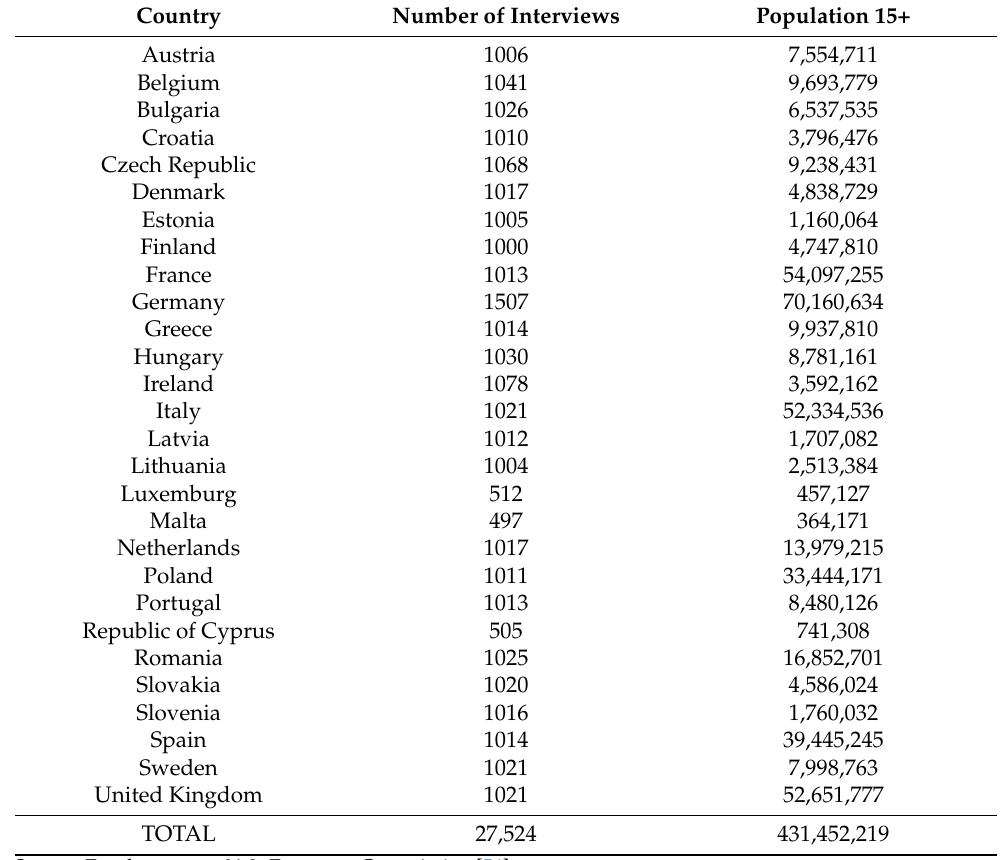
Table A1. Sample size by country, Total population older than 15 years